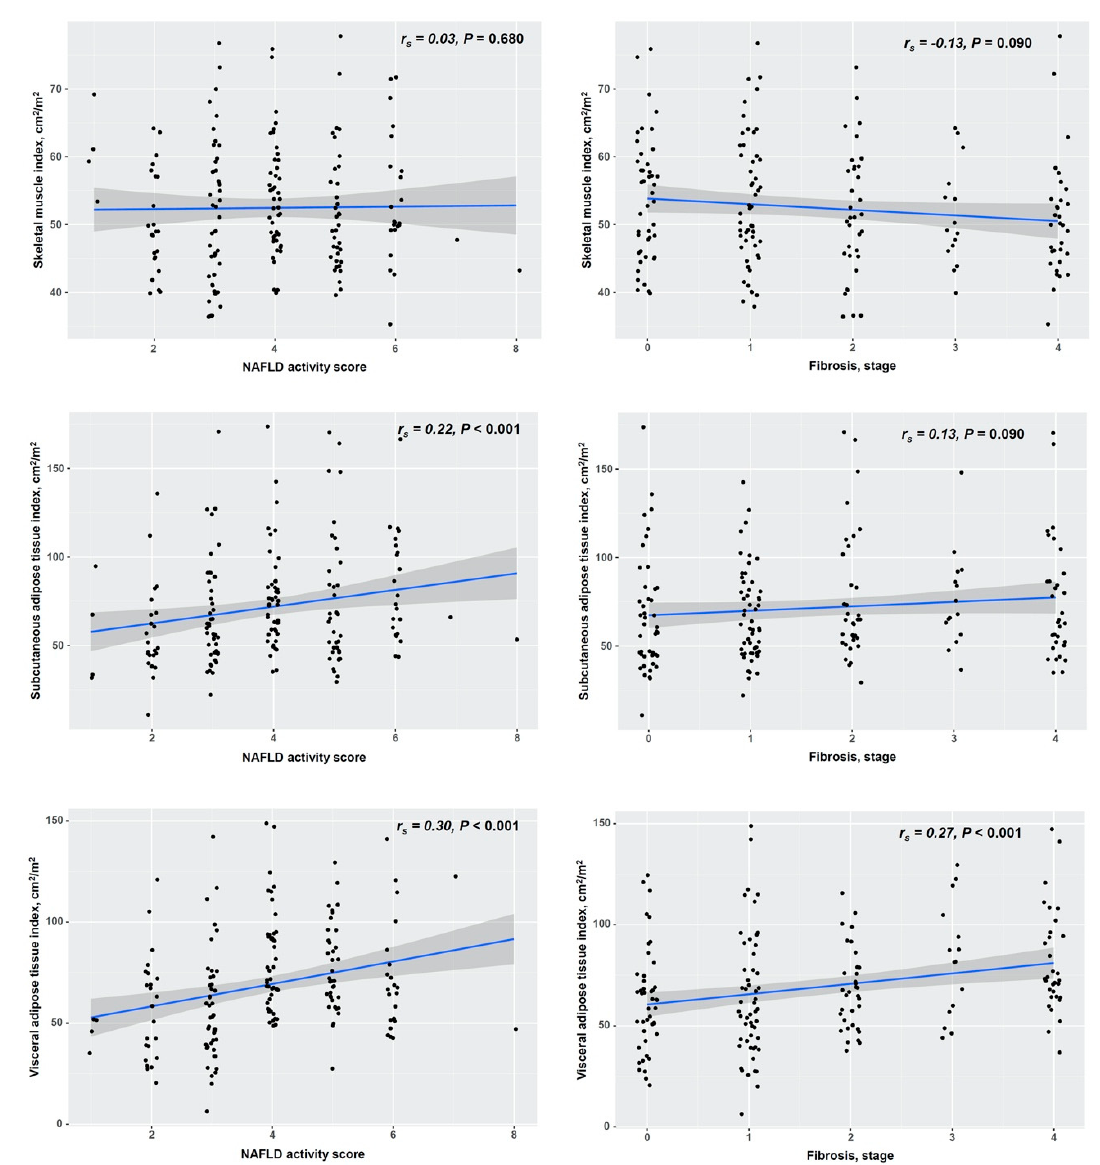
Figure 3. Correlation of adipose tissue distribution and skeletal muscle mass with the non-alcoholic fatty liver disease activity score and fibrosis stage. NAFLD, non-alcoholic fatty liver disease. The data were analyzed using Spearman’s cor- relation.